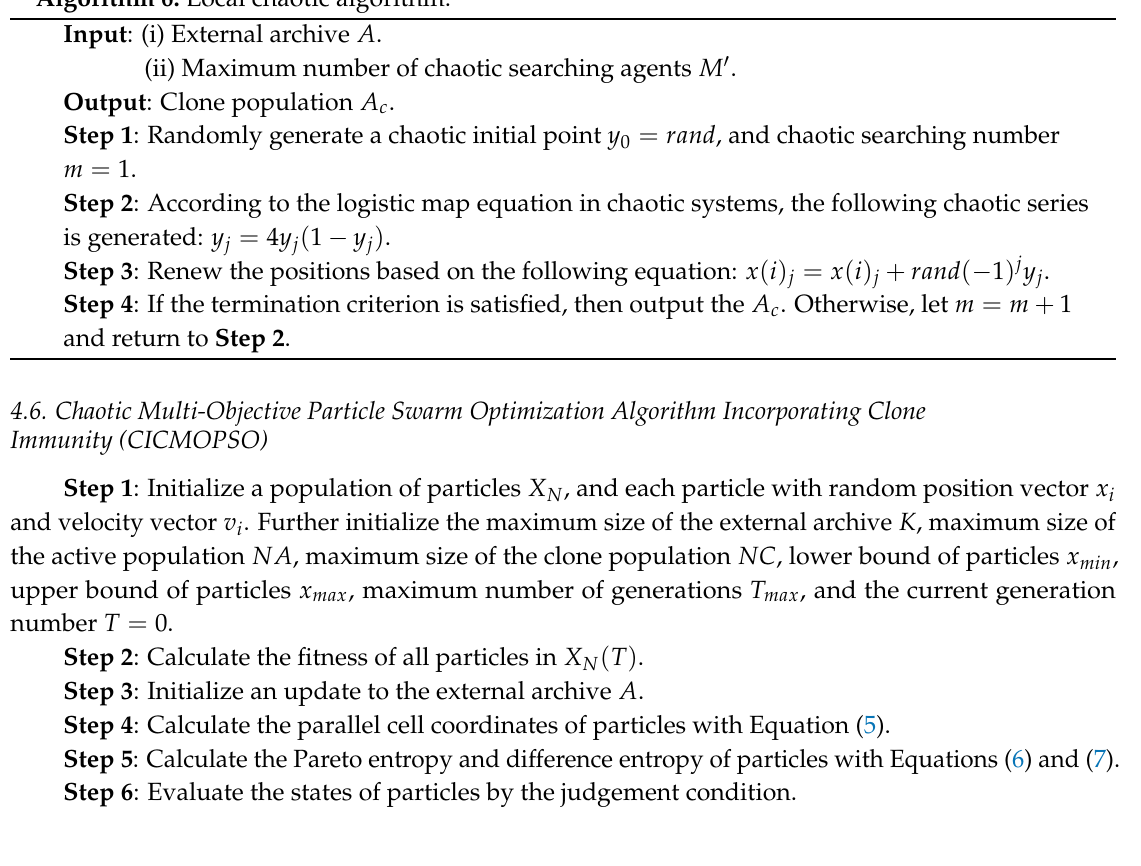
Algorithm 6: Local chaotic